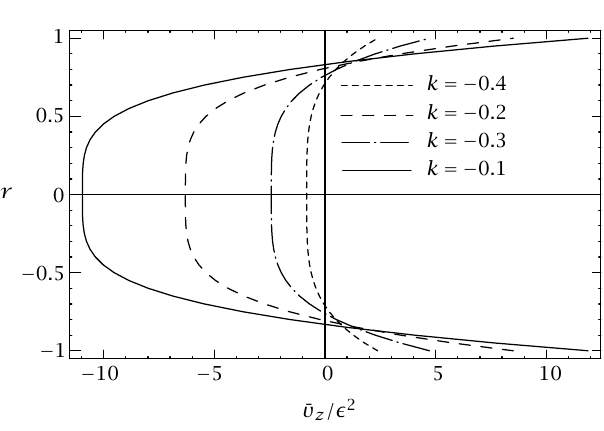
Figure 5.4 The effect of Poiseuille parameter k on the mean-velocity distri- bution and reversal flow at Re = 5 . 0 and (cid:23) = 0 . 15.